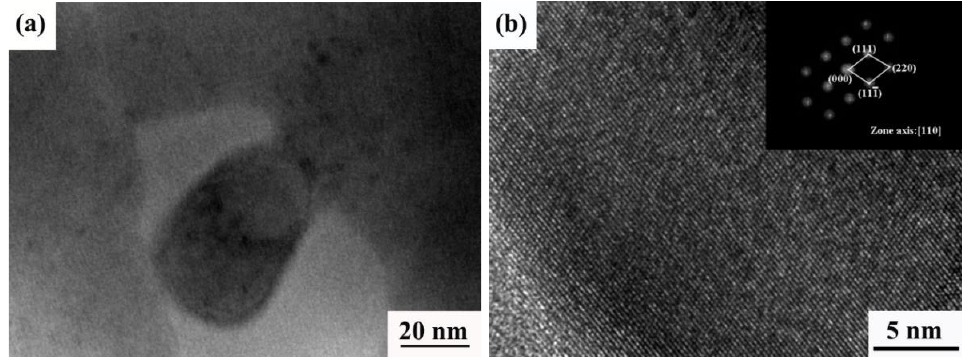
Figure 10. (a) High magnification TEM image of 950 – 848 process ;(b) High resolution micrographs image of 950 °C – 848 °C process.